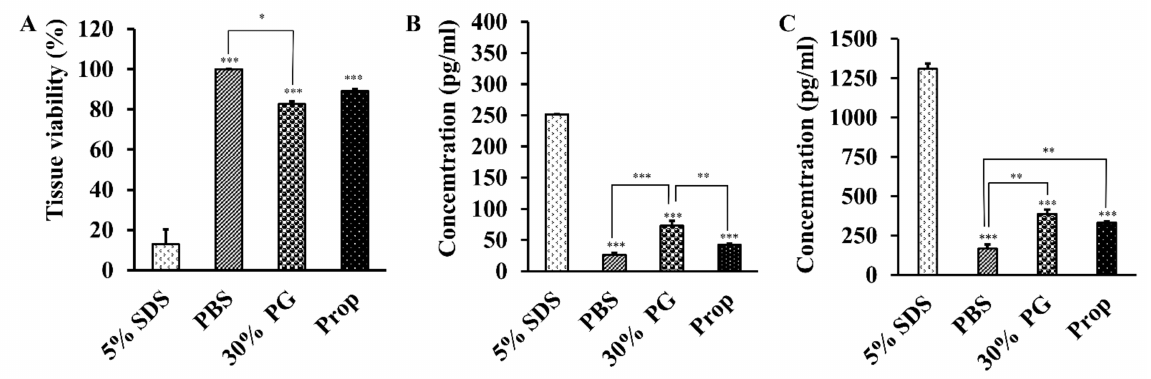
Figure 8. RHS results after treatment for 24 h with PBS, 30% PG, 5% w/v SDS, and blank proposome. ( A ) Tissue viability (%) measured using MTS assay. ( B ) IL- α and ( C ) IL-8 levels measured using ELISA kit. (N = 2, * p ≤ 0.05, ** p ≤ 0.01, *** p ≤